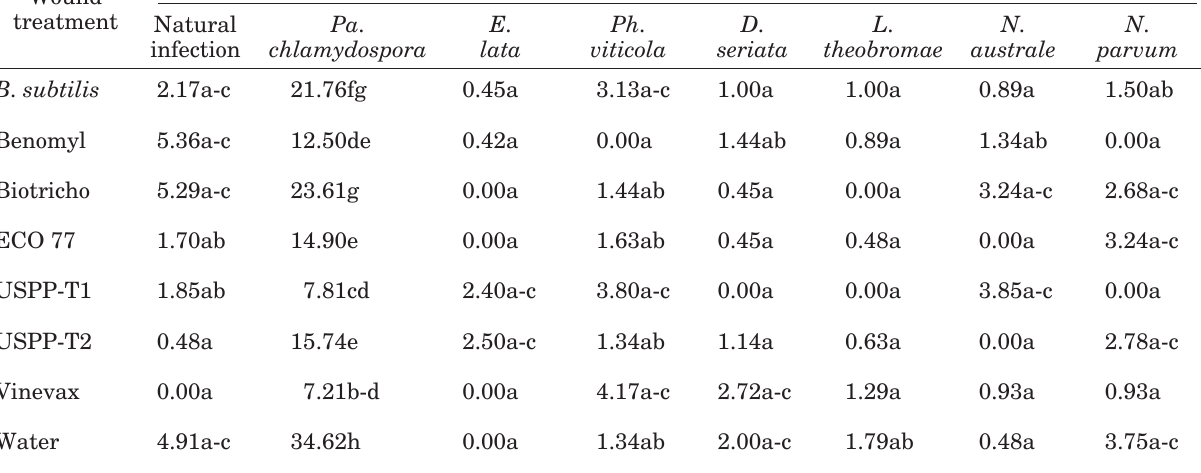
Table 6. Mean incidence of Phaeomoniella chlamydospora that was isolated from pruning wounds 8 months after the fresh pruning wounds were treated with benomyl, Bacillus subtilis , two Trichoderma spp. (USPP-T1 and -T2), three commercial Trichoderma -based biocontrol products or water as pruning wound protectants, and challenged 7 days later by spray-inoculation with Eutypa lata , Phaeomoniella chlamydospora , Phomopsis viticola , Diplodia seriata , Lasiodiplodia theobromae , Neofusicoccum australe and N. parvum spore suspensions, or sprayed with sterile water to evaluate natural